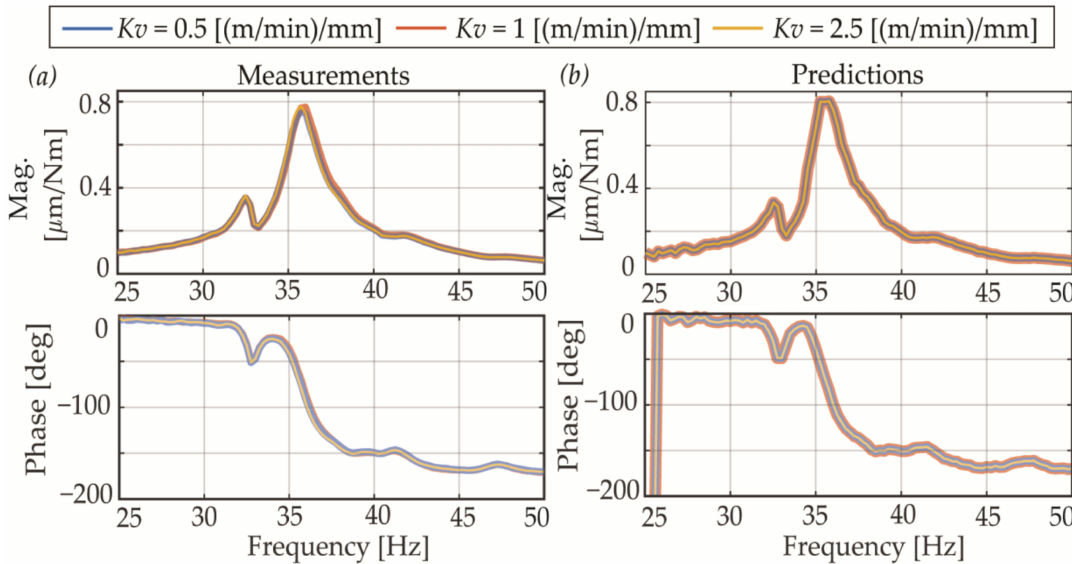
Figure 13. ( a ) Experimental, ( b ) Predicted closed-loop tool centre point